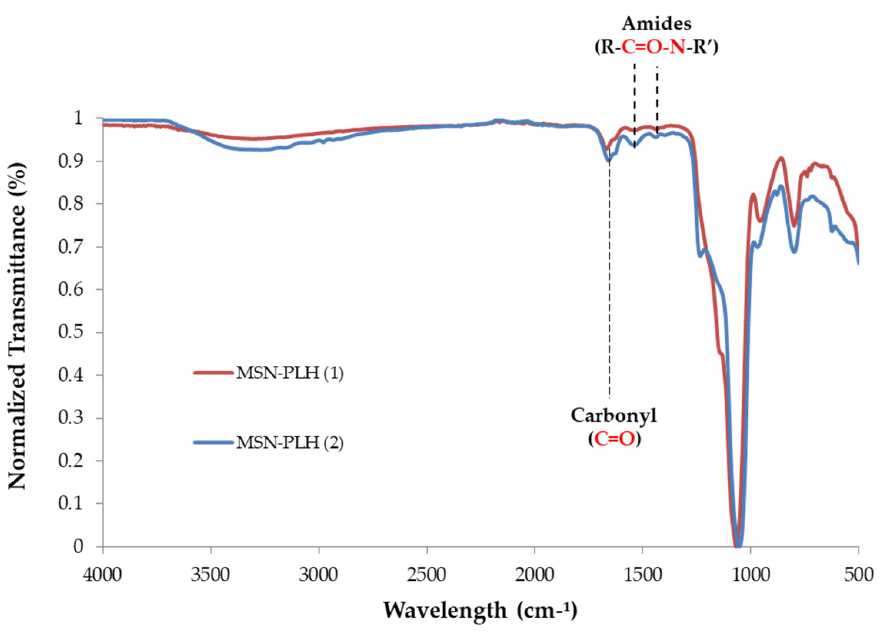
Figure 4. FT-IR spectra of MSN-PLH (1) and MSN-PLH (2).